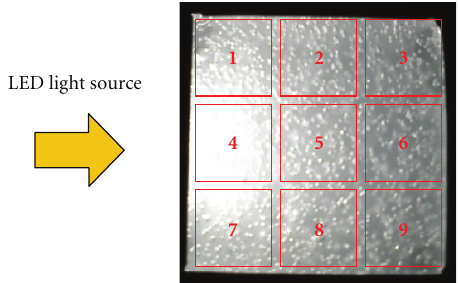
Figure 22: Embedded microvoids optical film with no structure + the reflection film.